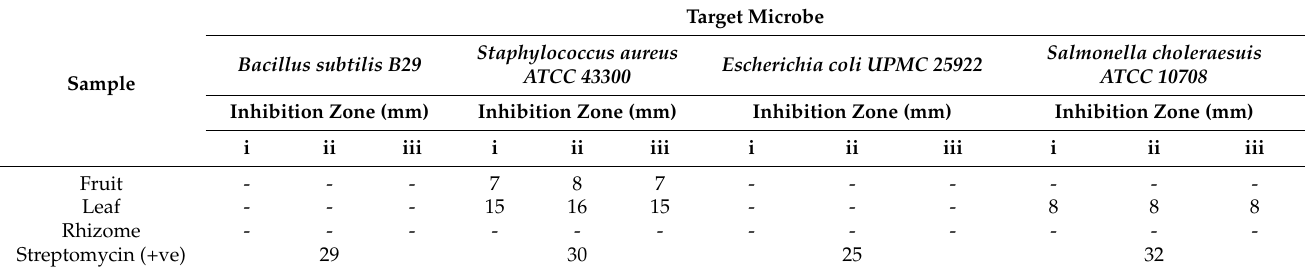
Table 4. Inhibition zones of Curculigo latifolia methanolic extracts against Bacillus subtilis B29, Staphylococcus aureus ATCC 43300, Escherichia coli UPMC 25922, and Salmonella choleraesuis ATCC 10708.